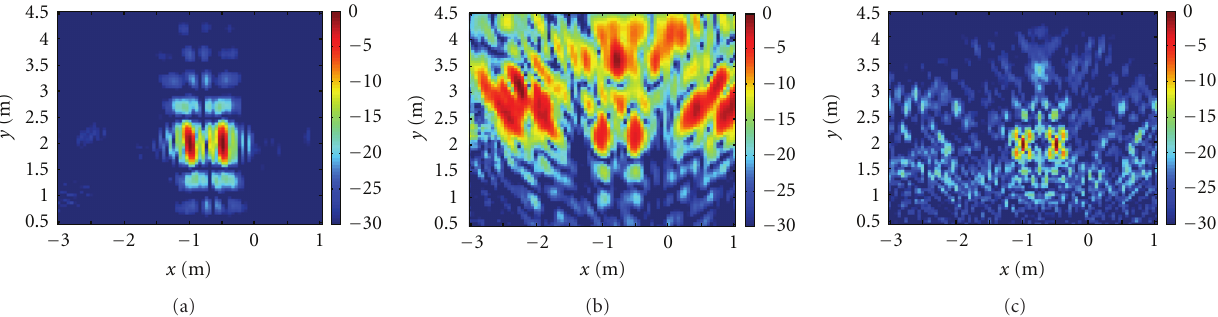
Figure 4: Back-projection images of the two point targets for the configuration in Figure 2 with data collected over the band 1.7–2.0 GHz: (a) Image in free space, (b) image in presence of the cinderblock wall using the free space Green’s function, (c) image in presence of the cinderblock wall using the periodic layer Green’s function.